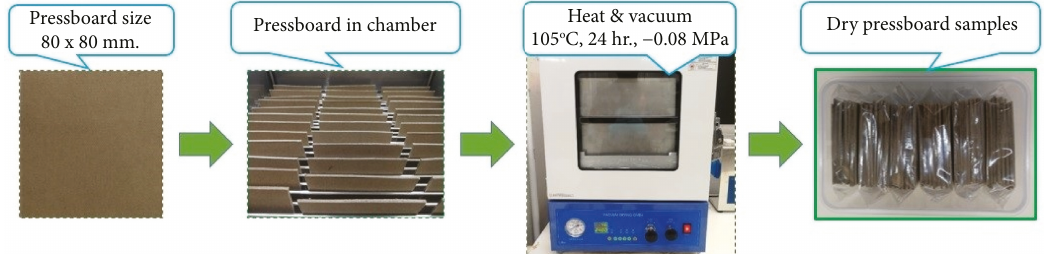
Figure 2: Preparation of pressboard samples.